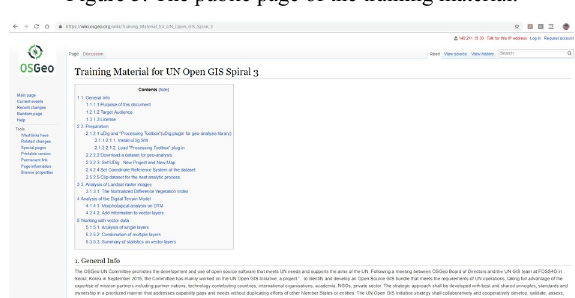
Figure 5. The public page of the training material.